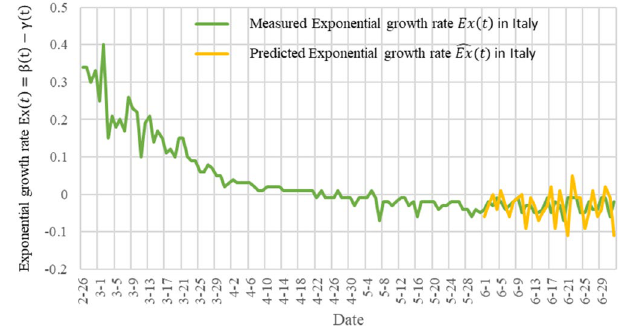
Figure 6. The basic number of infections Ex ( t ) and the predicted basic number of infections in Italy measured by the TW-SIR prediction model.